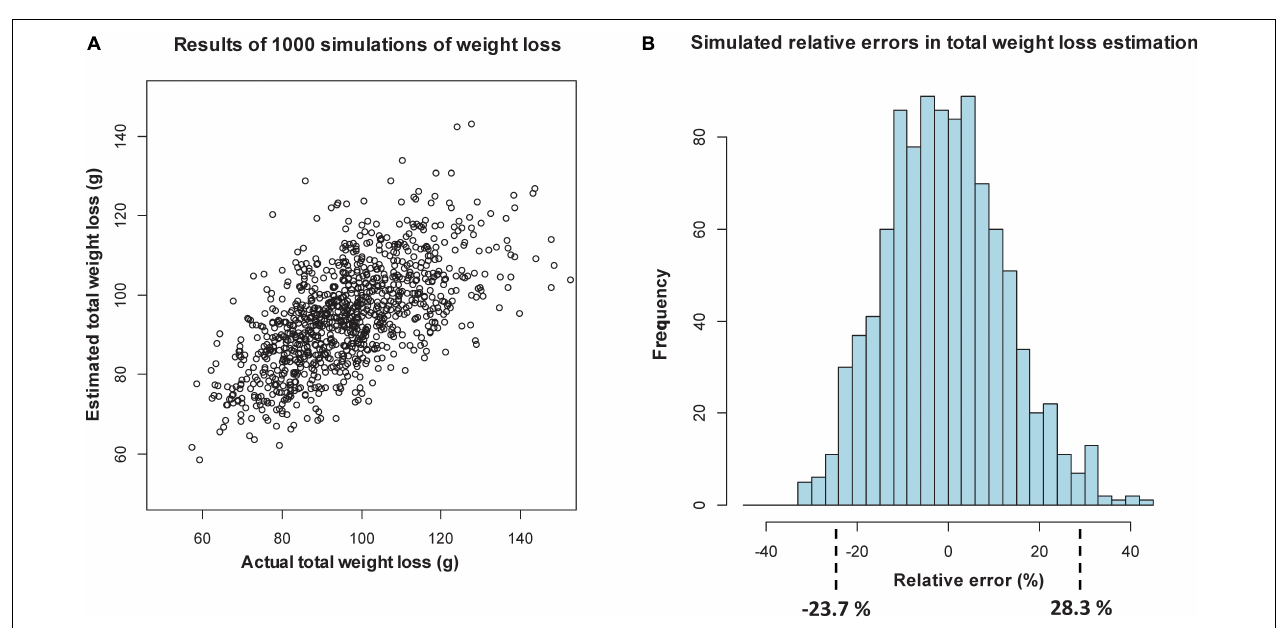
FIGURE 4 | Simulation of relative percentage errors from 1000 simulations of loss, using sectional regression models with only length data and days from deployment as predictors: scatterplot of estimated versus actual total weight loss (A) , and histogram of the relative percentage errors, showing intervals that include 95% of the values (B)